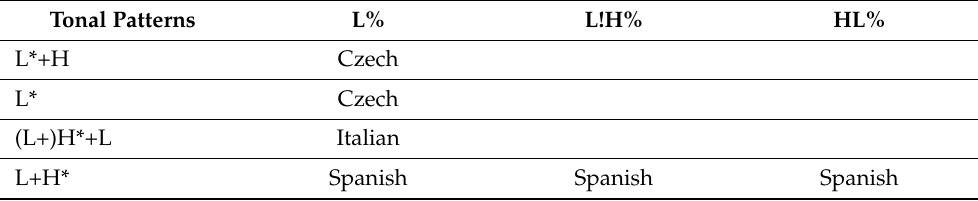
Table 1. Summary of the main tonal patterns of non-neutral statements in Czech, Italian and Spanish. Tonal Patterns